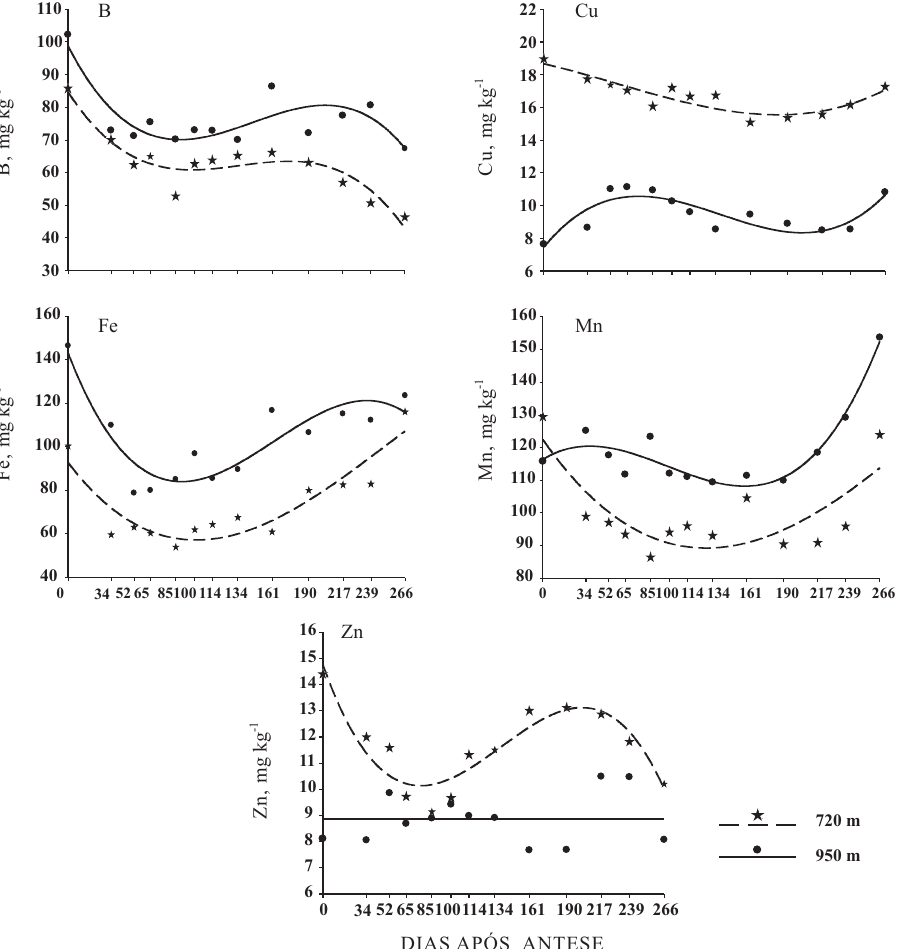
Figura 2. Variação na concentração de boro, cobre, ferro, manganês e zinco em folhas de cafeeiro em função do tempo decorrido após a antese, em duas